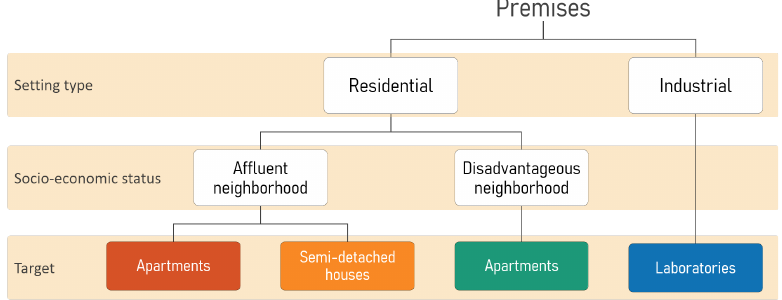
Figure 4. Premises targeted for MORED data